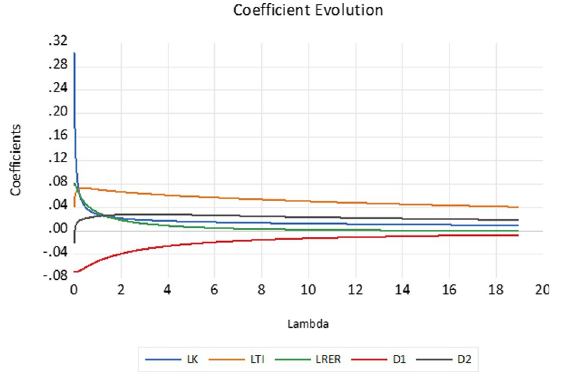
Fig 2. Ridge trace evolution plot. Estimated in EViews 10.